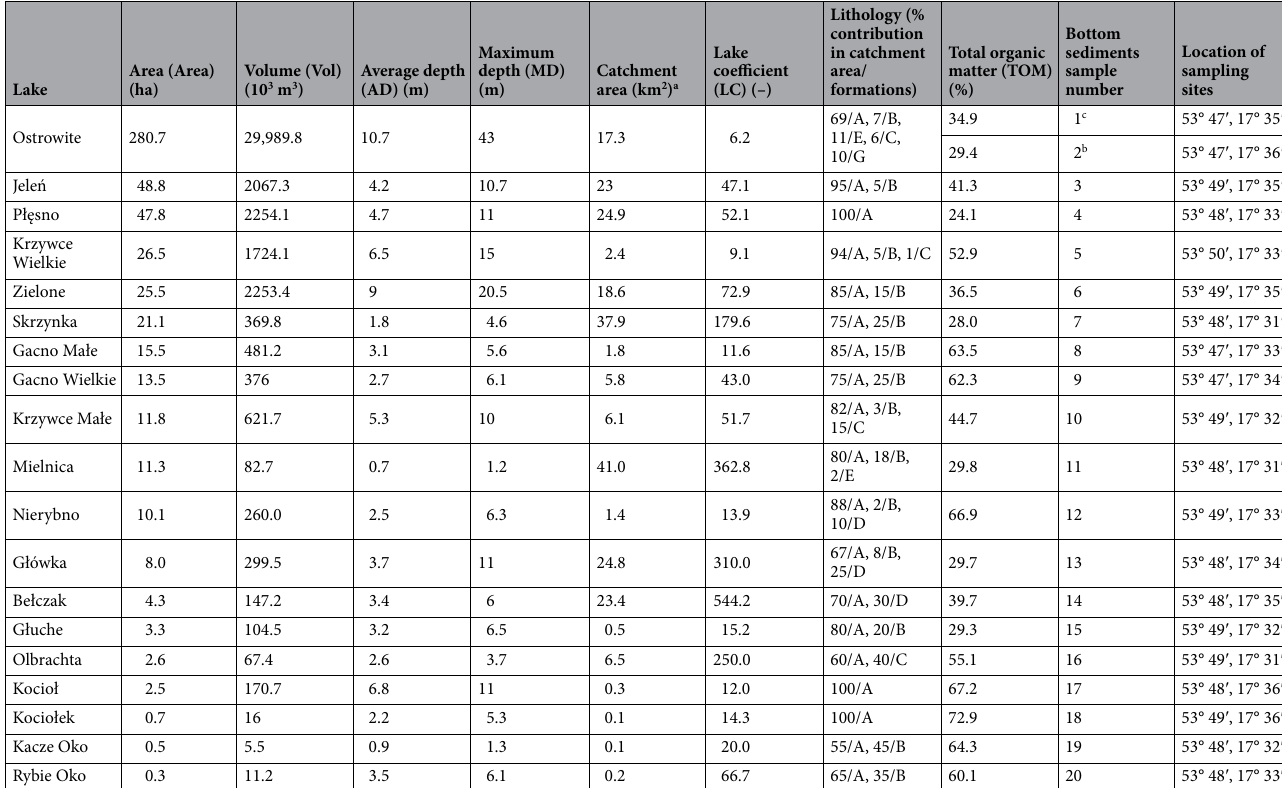
Table 1. Basic parameters of lakes in the BTNP. A outwash plain sands and gravels; B aeolian sands; C peats; D aggradate muds; E silts, limnic sands and chalks; F fluvial sands and gravels; G boulder loams. a Woronko and Nowicka 43 . b Eastern part. c Western